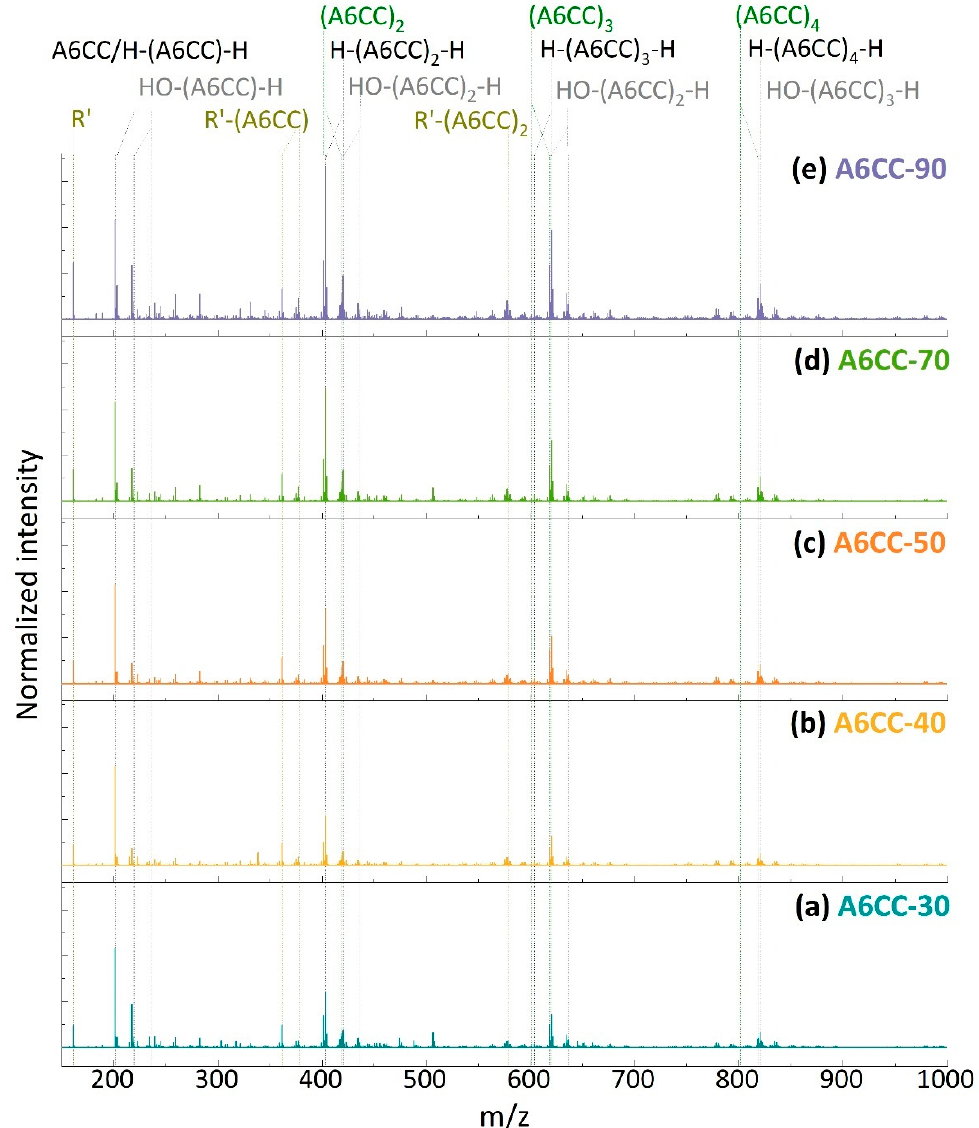
Figure 8. HRMS spectra of plasma-induced polymerization of A6CC in the mass range m / z = 150–1000 of ( a ) A6CC-30, ( b ) A6CC-40, ( c ) A6CC-50, ( d ) A6CC-70 and ( e ) A6CC-90. The data plotted are the result of the average spectra between 5.5 and 11 min, and the spectra were normalized to the monomer signal [A6CC + H + ]. The mass peaks resulting from the oligomer formation are indicated by dashed lines, where the color corresponds to the structures shown in Figure 9. The exact m / z values assigned to these structures are listed in Table S1.